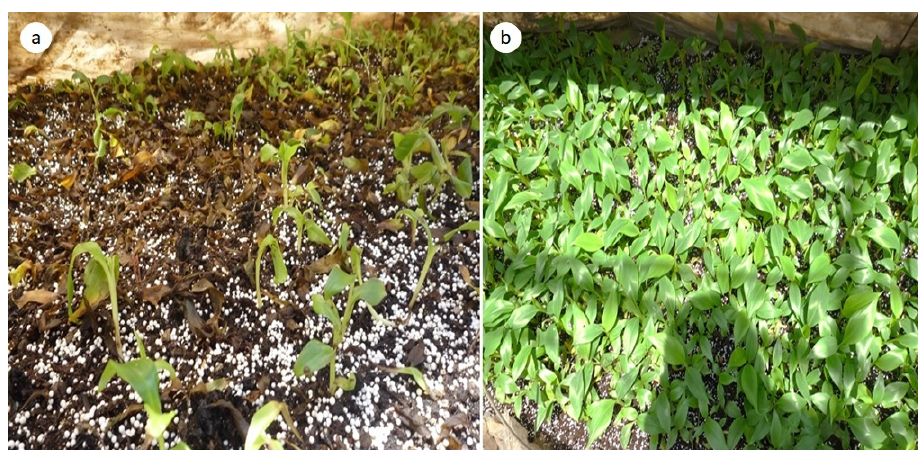
Figure 5. Impact of antibiotics supplementation (100 mg L − 1 ticarcillin) to the in vitro contaminated banana culture on its growth and survival during acclimatization in greenhouse. ( a ) Non-treated plantlets (control); ( b ) treated plantlets.